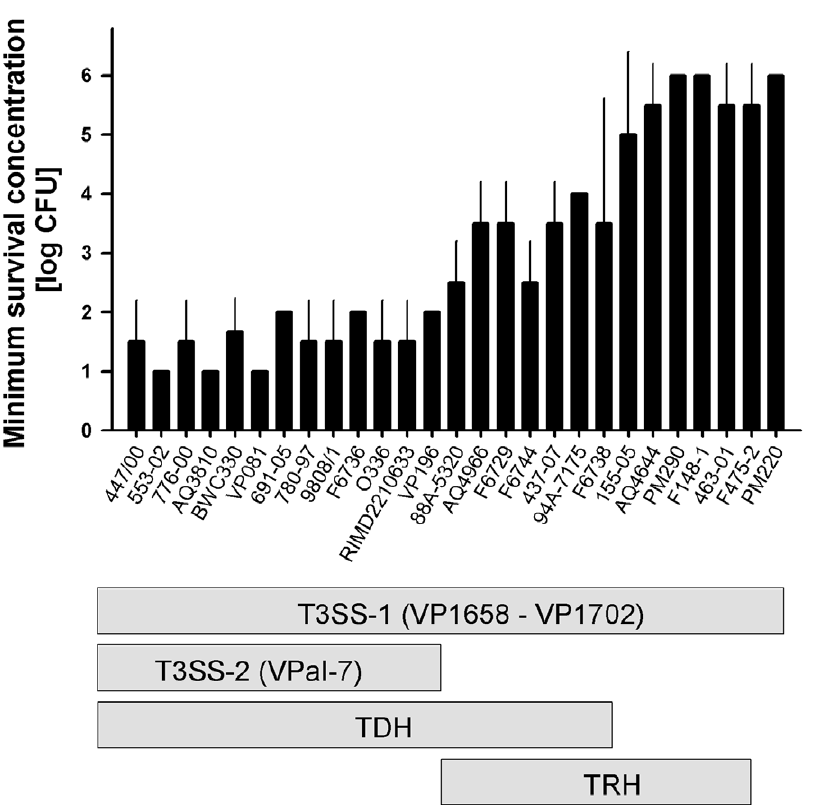
Figure 3. Antipredator effects correlate with T3SS-2 and TDH genotype in environmental and clinical strains of V.parahaemolyticus . Minimum survival concentrations of 27 strains of V. parahaemolyticus were calculated from the minimum bacterial concentration to form robust colony forming units on amoeba-seeded agar plates. Error bars indicate standard deviations of three repeated experiments.